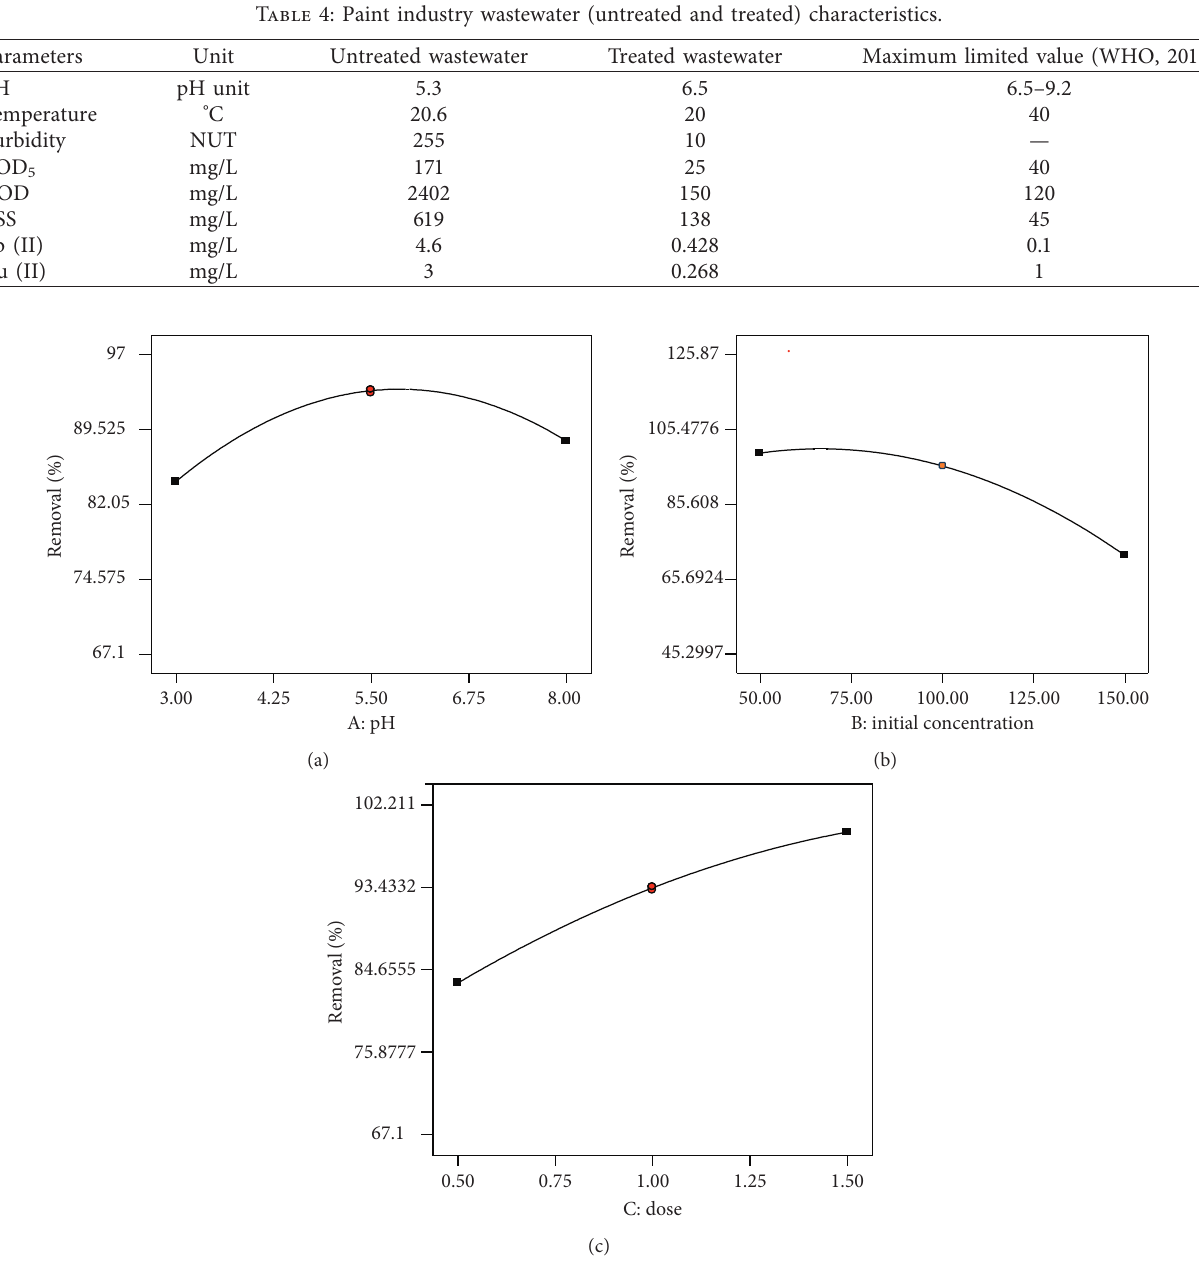
Figure 3: Individual effects of pH (a); initial Pb (II) ions concentration (b); and adsorbent dosage (c) on Pb (II) adsorption by